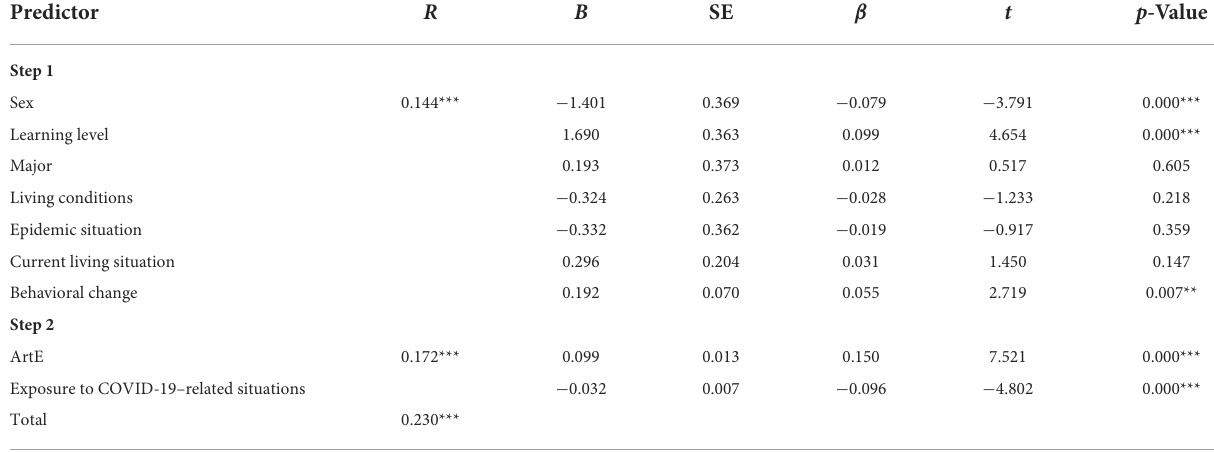
TABLE 6 Hierarchical multiple linear regression for predicting resilience.